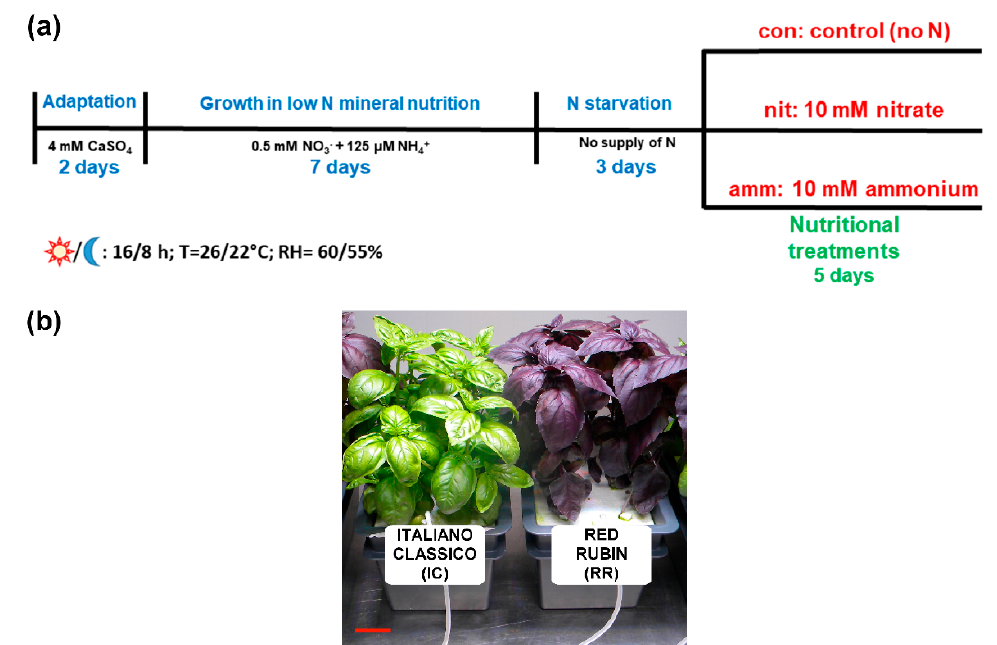
Figure 1. Hydroponics of green and purple basil. ( a ) Outline of the experimental hydroponic design. Young basil plants grown in soil were adapted (2 d) to the hydroponic condition and then grown for 7 d in low N mineral nutrition until the adult vegetative phase was reached. After 3 d of N starvation, plants were exposed for 5 d to: absence of N—control [con], 10 mM NO 3 − —nitrate [nit], or 10 mM NH 4 + —ammonium [amm]. For details, see the Materials and Methods section. ( b ) Basil plants of the green ‘Italiano Classico’ (IC, on the left) and of the purple ‘Red Rubin’ (RR, on the right) cultivars grown in hydroponics up to the adult vegetative phase; red scale bar = 5 cm.